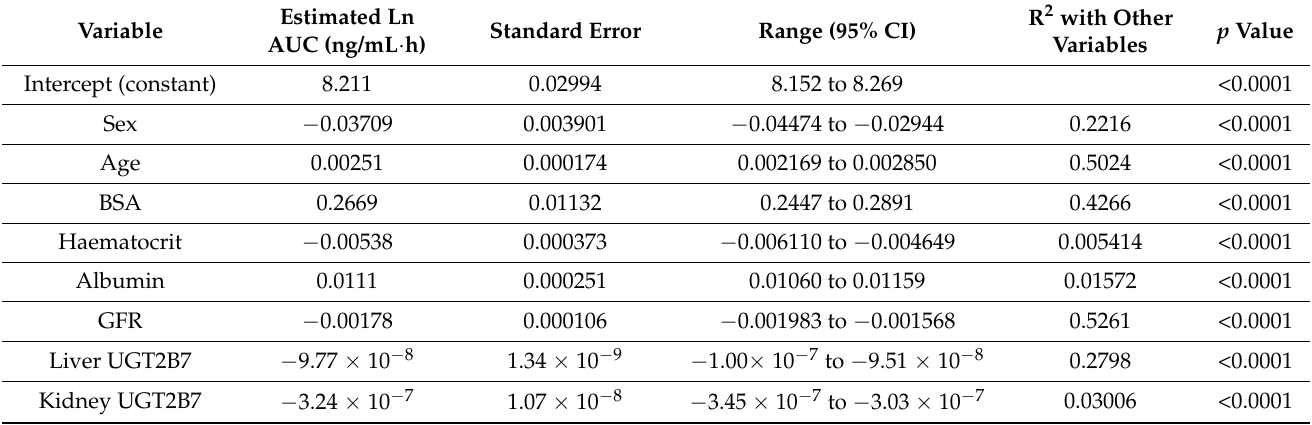
Table 6. PBPK-predicted epirubicin mean Cmax (ng/mL) and mean AUC (ng/mL·h) in tissue and plasma over 168 h after IV injection in a Sim-Cancer population.